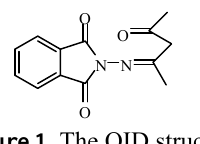
Figure 1. The OID